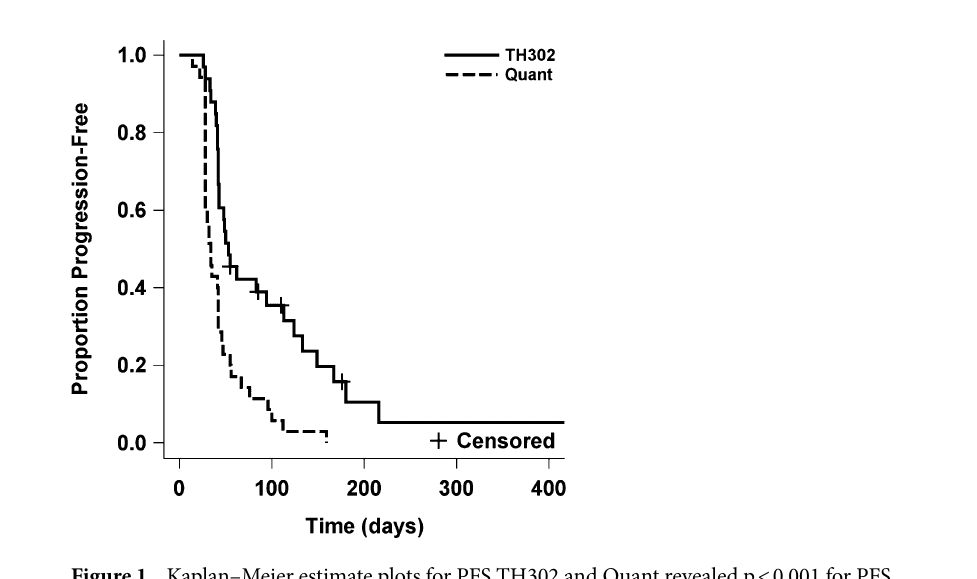
Figure 1. Kaplan–Meier estimate plots for PFS TH302 and Quant revealed p < 0.001 for PFS.